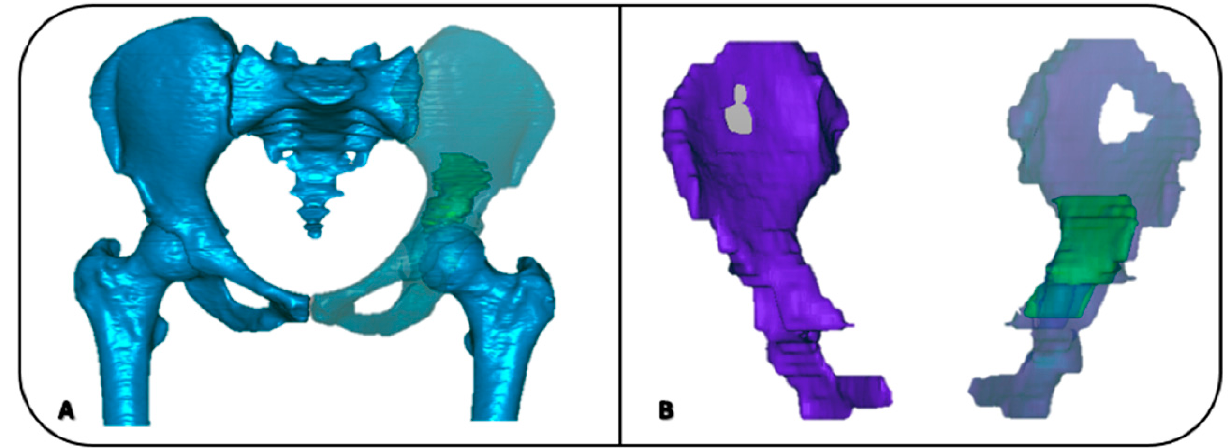
Figure 2. ( A ) 3D bone models (blue) obtained by segmentation from CT images, including pelvis, sacrum and femur bones. ( B ) 3D model of the pelvis (purple) obtained by segmentation from MRI images. In both the 3D models of the tumor on the left hemipelvis is depicted in green.